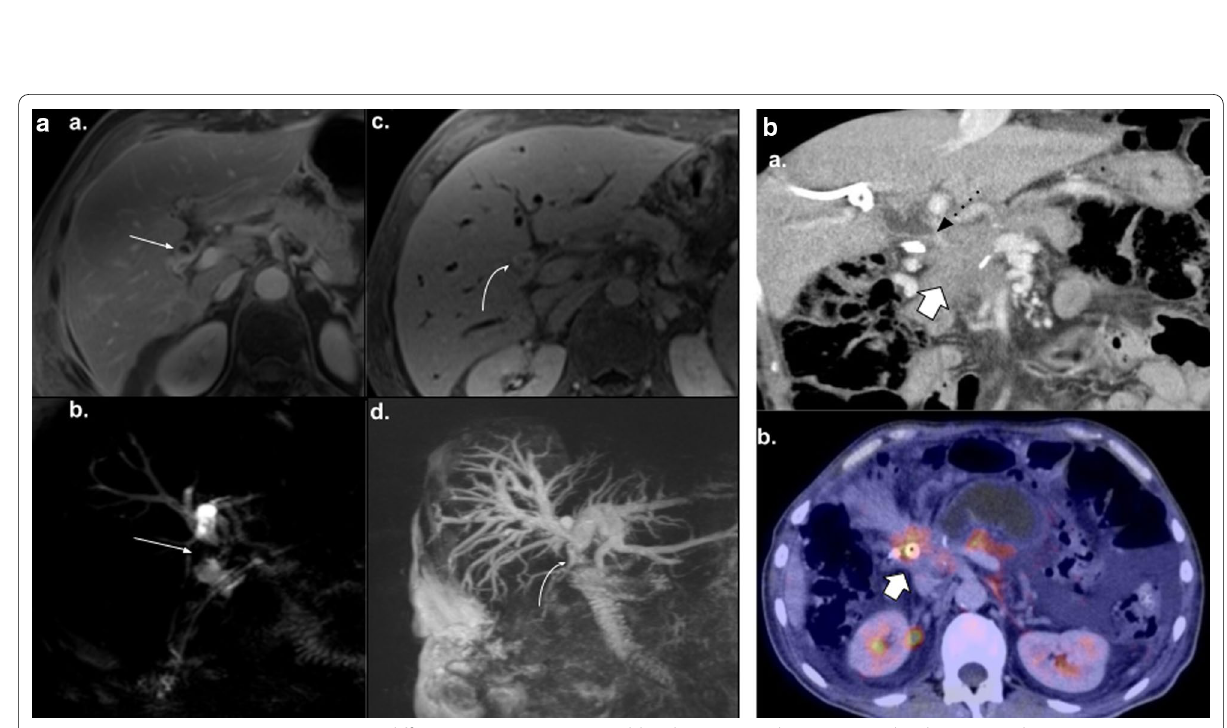
Fig. 21 Hepaticojejunostomy stenosis. Two different patients ( a ) 67-year-old male patient with pancreaticoduodenectomy due to cholangiocarcinoma. All images below to normal postoperative control MRI. (a, b) one month after surgery (c, d) 7 months control. Note the caliber reduction in hepaticojejunostomy due to thickness of hepatic bile duct (curved arrows). Intraoperative cholangiography confirmed total hepaticojejunostomy stenosis (not shown) ( b ) 59-year-old male patient with abdominal discomfort and unexplained weight loss two years after pancreaticoduodenectomy owing to adenocarcinoma. CT scan denotes abrupt intrahepatic biliary stenosis (dotted arrow) due to ill-defined mass (big arrow). PET/CT fusion confirms local tumor recurrence as causal of